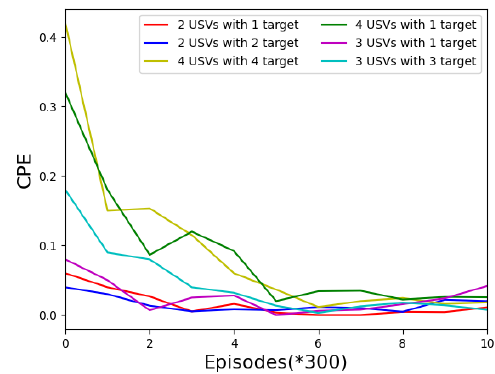
Figure 5. Collision rate in total episodes for the different numbers of USVs under the MADDPG algorithm.